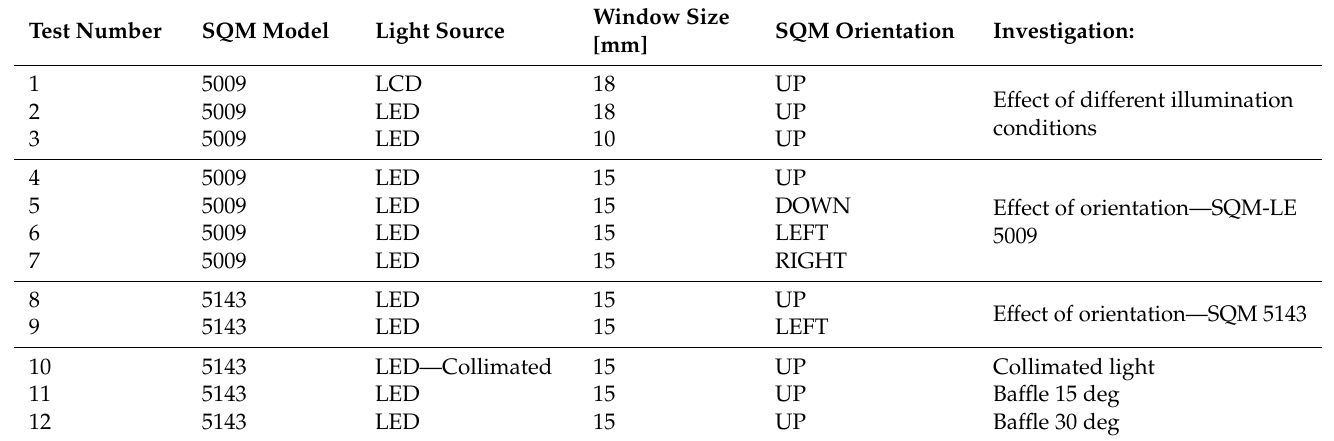
Table 1. List of tests performed in the experimental